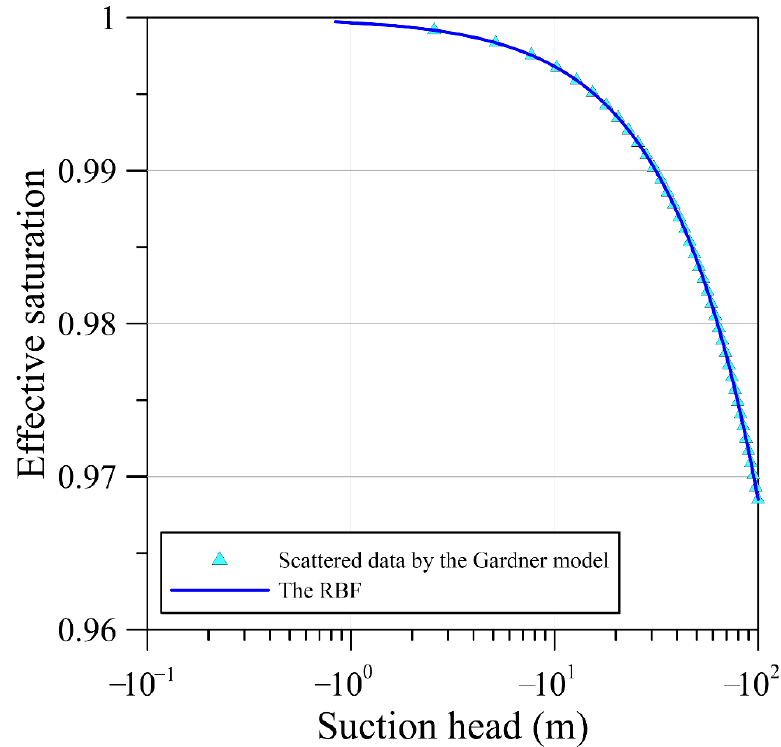
Figure 5. Comparing effective saturation using RBF with scattered data by the Gardner model.